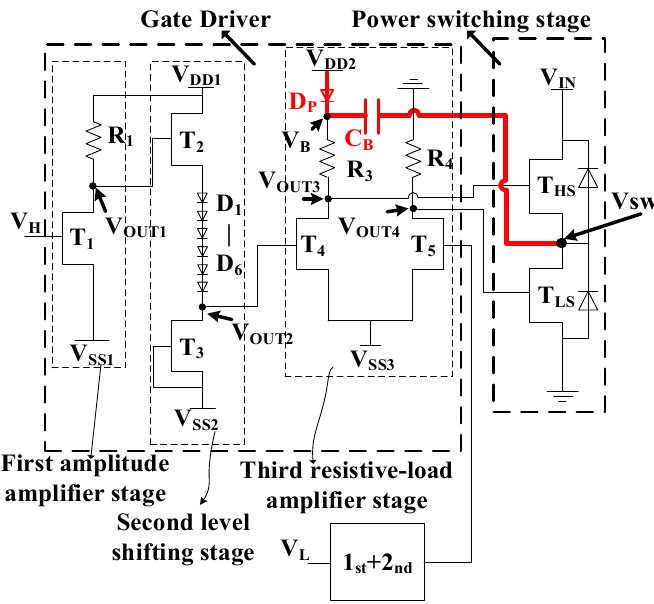
Figure 6. Schematic of two topologies for GaN DC-DC converter: without the bootstrapped capacitor (not including the red bold line path) and with the bootstrapped capacitor (include the red bold line path). Electronics 2020 , 9 , x FOR PEER REVIEW